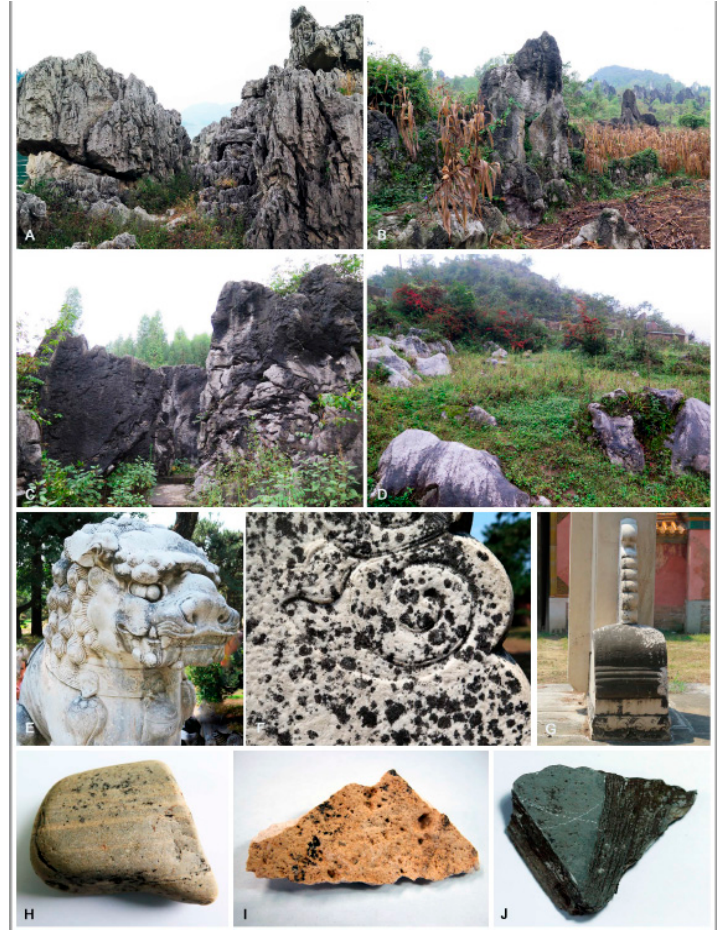
Figure 1. Rock-inhabiting fungi (RIF) colonizing natural rock and historical stone monuments. ( A – D ) Representative sampling sites in the Karst landform area in Guizhou Province, ( E – G ) RIF colonizing on historical monuments in Beijing, ( H – I ) rock with RIF sampled from Tibet, and ( J ) rock with RIF sampled from Guizhou